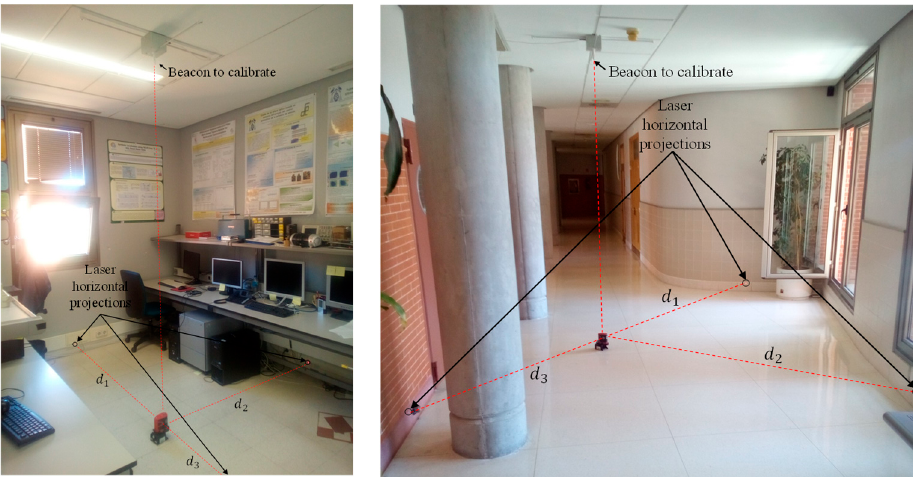
Figure 11. Experimental calibration of two ULPSs placed on similar locations than those used for the simulated results. Beacon #1 (left) placed on the ceiling of a laboratory and beacon #2 (right) located on the ceiling of a corridor.